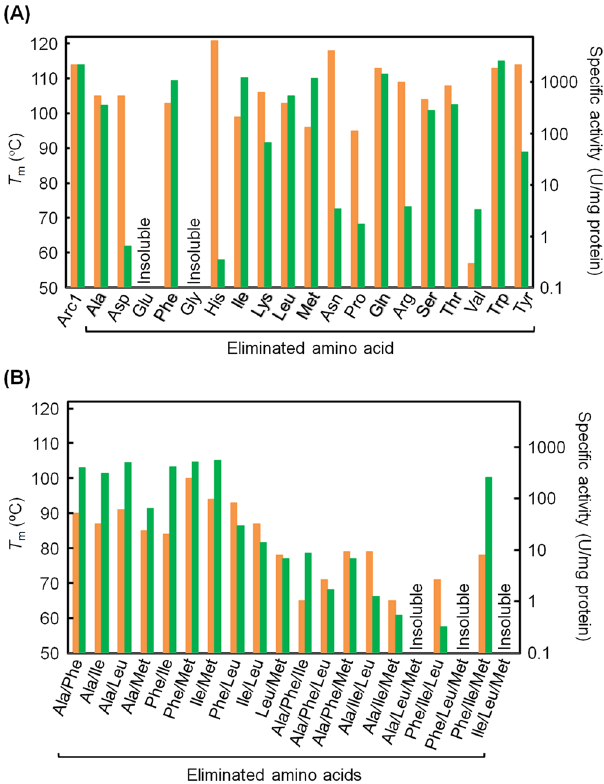
Figure 1. Thermal stabilities and specific activities of Arc1 and its simplified variants. ( A ) T m (orange) and specific activities (green) for Arc1 and its simplified variants, each devoid of one amino acid letter. Specific activity of the variant devoid of valine was determined at 50 °C and those of all other proteins were at 70 °C. ( B ) T m and specific activity at 70 °C for simplified variants devoid of multiple amino acid